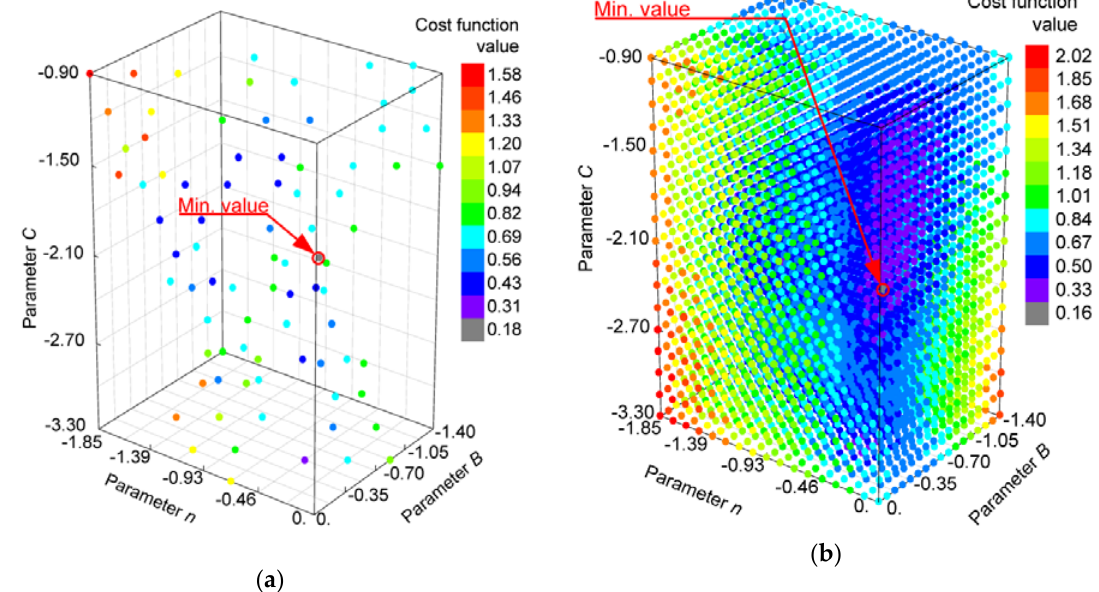
Figure 5. ( a ) Points defined by Taguchi array (TA); ( b ) The corresponding response surface (logarithmic values).